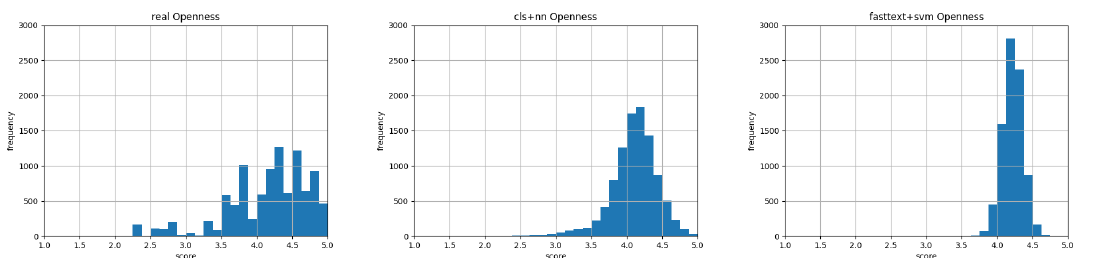
Figure 6. Openness: Histograms representing data distribution of gold standard on the left, our model result in the middle, and previous state of the art by Carducci et al. [8] on the